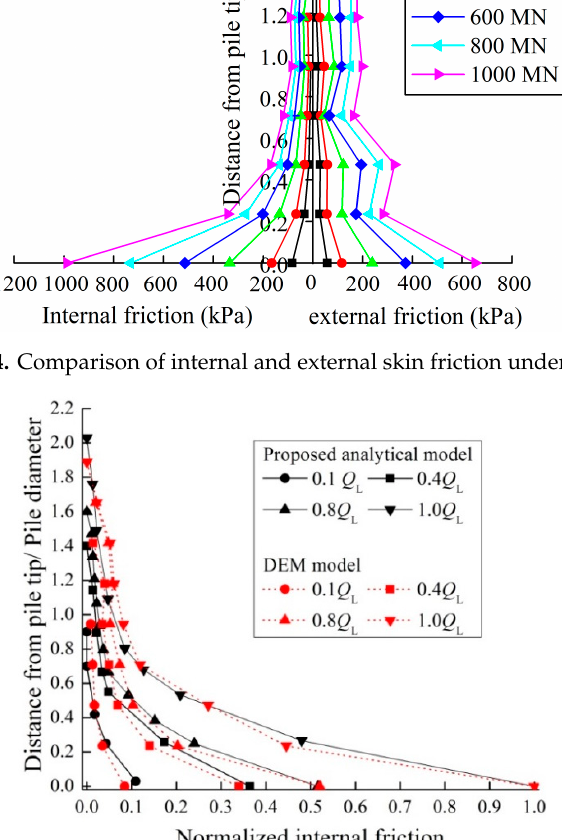
Figure 16. The external friction from the analytical method and DEM model. Figure 17. The axial force-depth from the analytical method and DEM model.